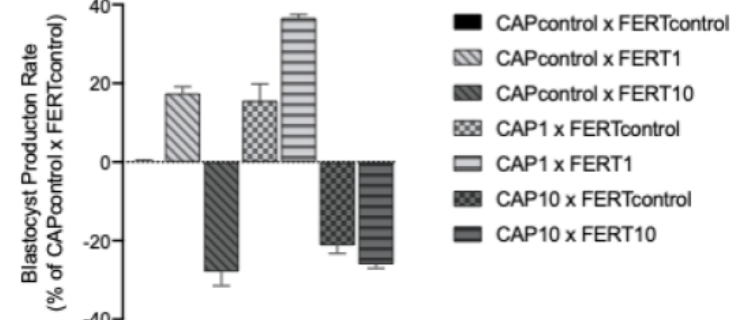
Figure 4. Effects of the mitochondria-targeted hydroxybenzoic acid derivative AntiOxBEN2 supple- mentation during capacitation and fertilization processes on Day 7 embryo production rates. Results from all groups were normalized by using the CAPcontrol × FERTcontrol group blastocyst rate. CAPcontrol: capacitation medium without supplementation; CAP1: capacitation medium supple- mented with 1 µM of AntiOxBEN2; CAP10: capacitation medium supplemented with 10 µM of An- tiOxBEN2; FERTcontrol: fertilization medium without supplementation; FERT1: fertilization me- dium supplemented with 1 µM of AntiOxBEN2; FERT10: fertilization medium supplemented with